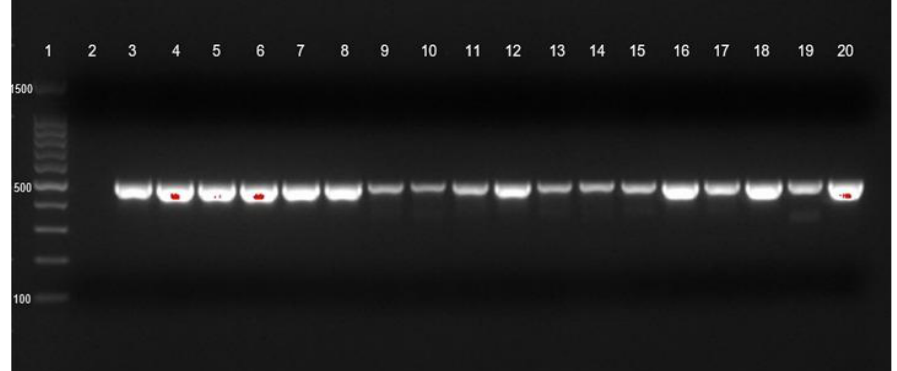
Figure 2. blaOXA-23 gene identification of CRAb-cc isolates from Dr. Saiful Anwar Hospital, Malang. Lane 1 = DNA ladder; lane 2 = negative control; lane 3 = positive control; blaOXA-23 was detected in lanes 4 to 20. Table 1. Gene primers used for PCR amplification of antibiotic resistance genes in clinical CRAB-cc isolates.